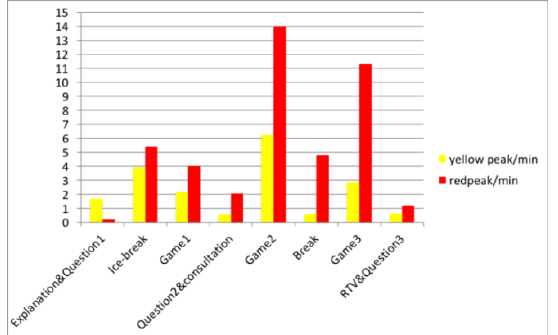
Figure 13 Students' sound analyzing in each part of the game workshop